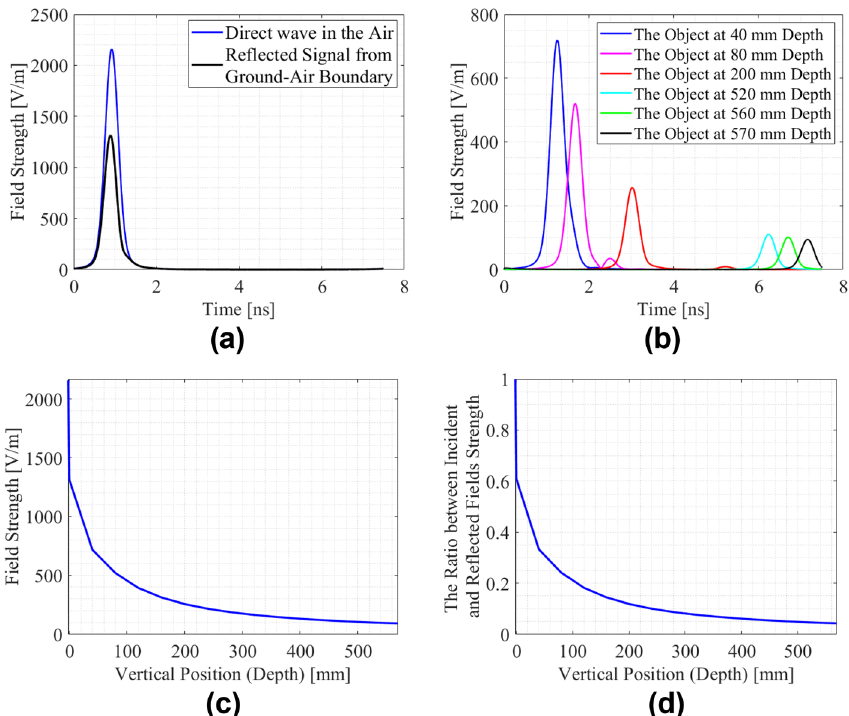
Figure 4. Reflected Signals from air-ground boundary and the objects in different depths with their enveloped forms: ( a ) the received direct wave in the air and reflection from the air-ground boundary; ( b ) sample scenarios of the A-scan to obtain soil attenuation along the penetration path with the object set at D = 40 mm, 80 mm 200 mm, 520 mm, 560 mm, 570 mm, and P = 238 mm as well as R = 10 mm; ( c ) amplitude change of the reflected signals versus the depth due to soil attenuation; ( d ) amplitude ratio between the incident signal and the reflected signals versus the